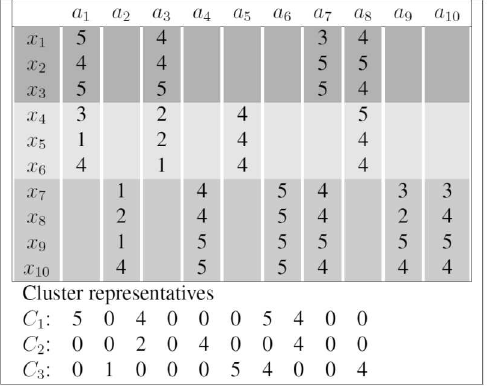
Calculation of a representative vector of clusters in the approach described by Equation